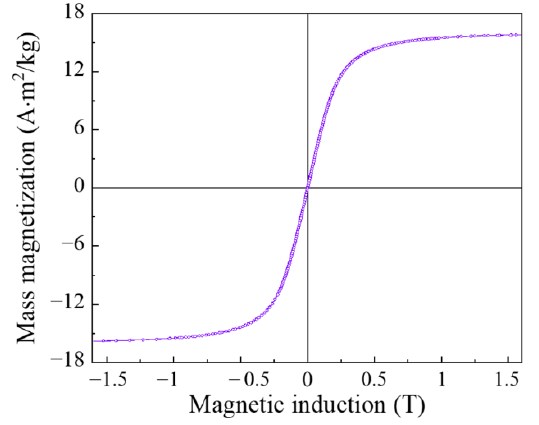
Figure 3. Magnetization curve of a composite material containing 3.8% flakes and 2% CNT.